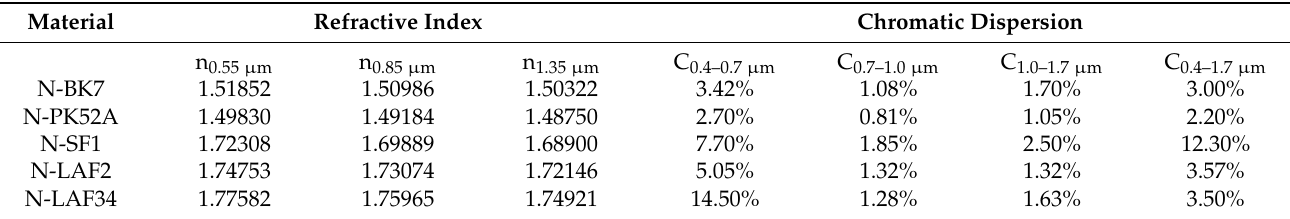
Table 1. Performance of five optical glasses in 0.4~1.7 µ